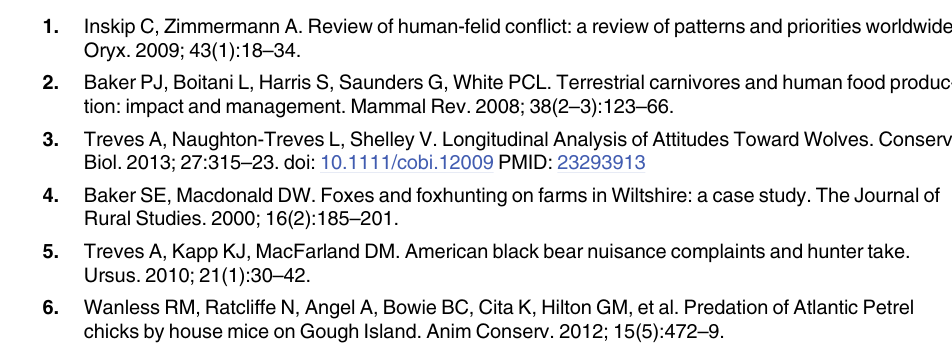
S10 Table. Welfare assessment for shooting rabbits (chest shot). (PDF) S11 Table. Welfare assessment for fencing against rabbits (fence installation). (PDF) S12 Table. Welfare assessment for fencing against rabbits (fence established). (PDF) S13 Table. Welfare assessment for managing molehills on lawns. (PDF) S14 Table. Welfare assessment for spring trapping moles. (PDF) S15 Table. Welfare assessment for live-trapping moles. (PDF) S16 Table. Welfare assessment for translocating moles. (PDF) S17 Table. Welfare assessment of shooting crows. (PDF) S18 Table. Welfare assessment for scaring crows. (PDF) S19 Table. Welfare assessment for cage-trapping and cervical dislocation of crows.